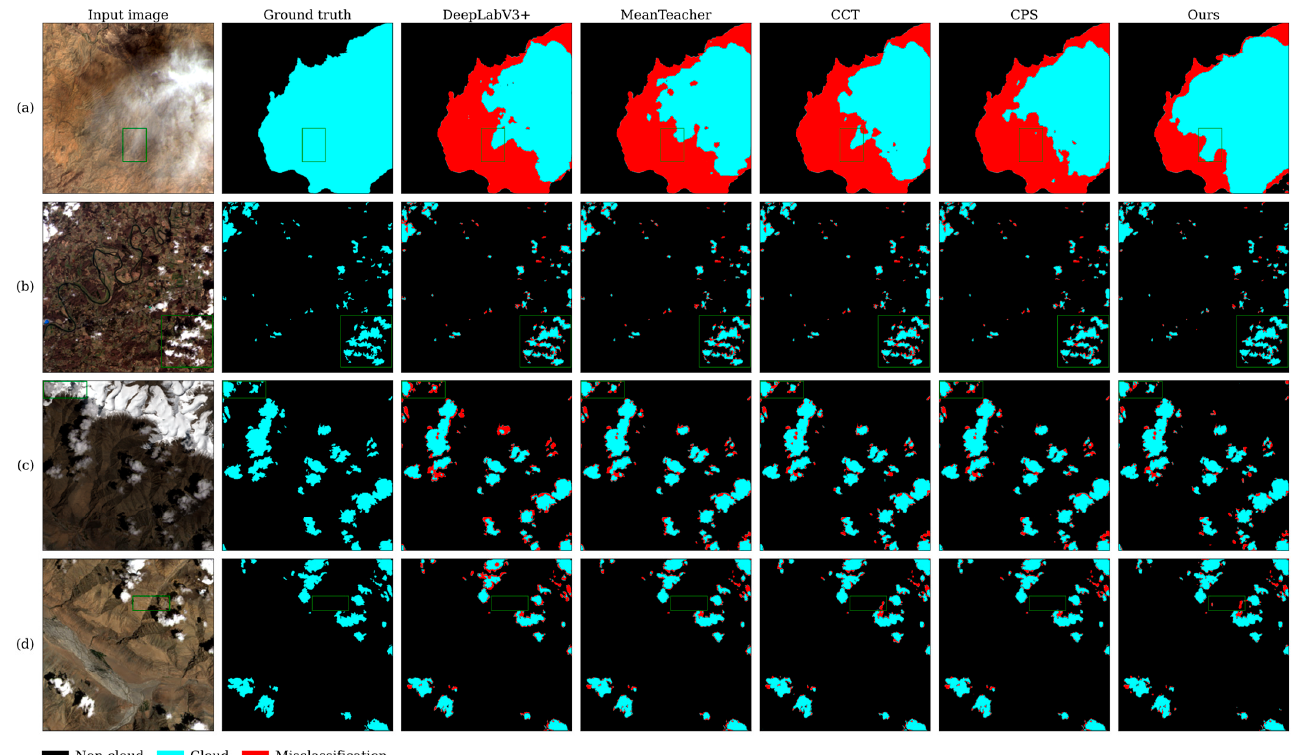
Figure 5. Examples of cloud detection results on the SPARCS dataset at the labeled ratio of 1/2. ( a ) thin clouds at the edge of thick clouds, ( b ) finely-broken clouds, ( c ) clouds over snow, ( d ) thin clouds (not marked in the ground truth).